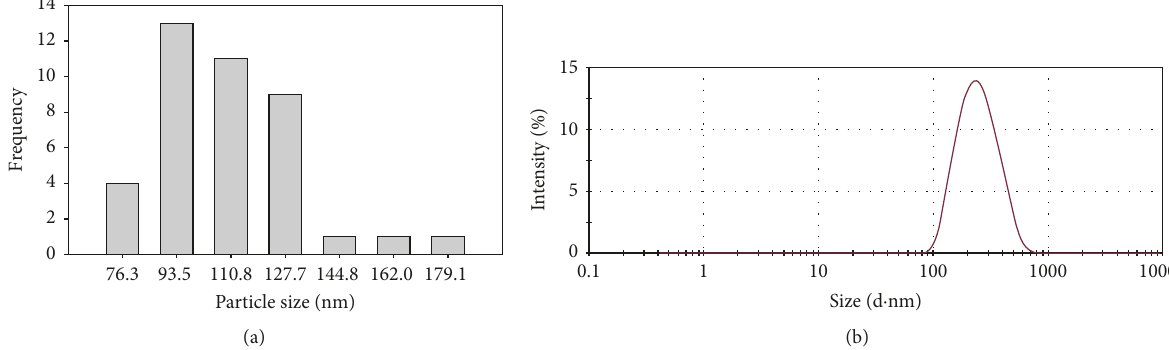
Figure 5: (a) Histogram with the distribution of particle size measure by TEM. (b) Distribution of particle size obtained by